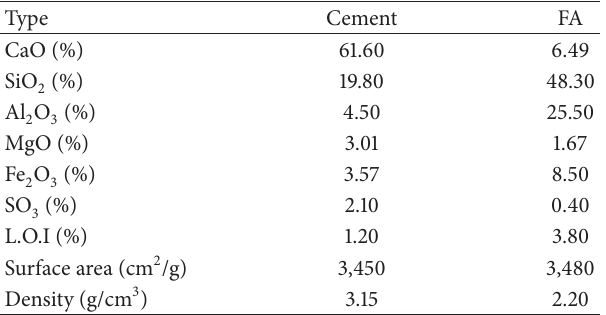
Table 1: Chemical compositions and physical properties of cement and FA.